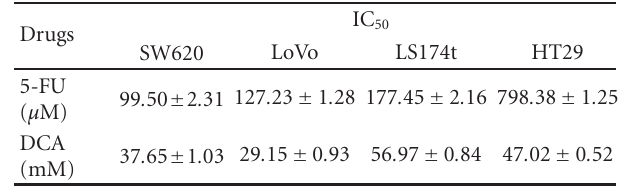
Table 1: IC 50 values (concentrations required to reduce the viability of cells by 50% as compared with the control cells) were computed using linear or nonlinear regression (three parametric Hill func- tion) ( R 2 > 0 . 9). They are presented as mean ± SD from at least three independent experiments. IC 50 values of the studied drugs for inhibition of growth of various cell lines (cells were incubated with drugs for 48hours).